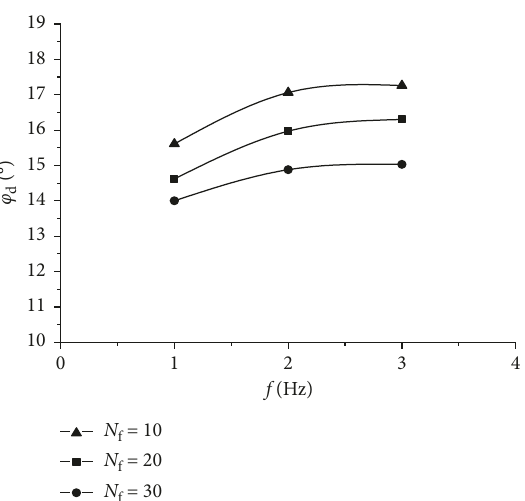
Figure 10: Relationship curves between dynamic internal friction angle and vibration frequency under different